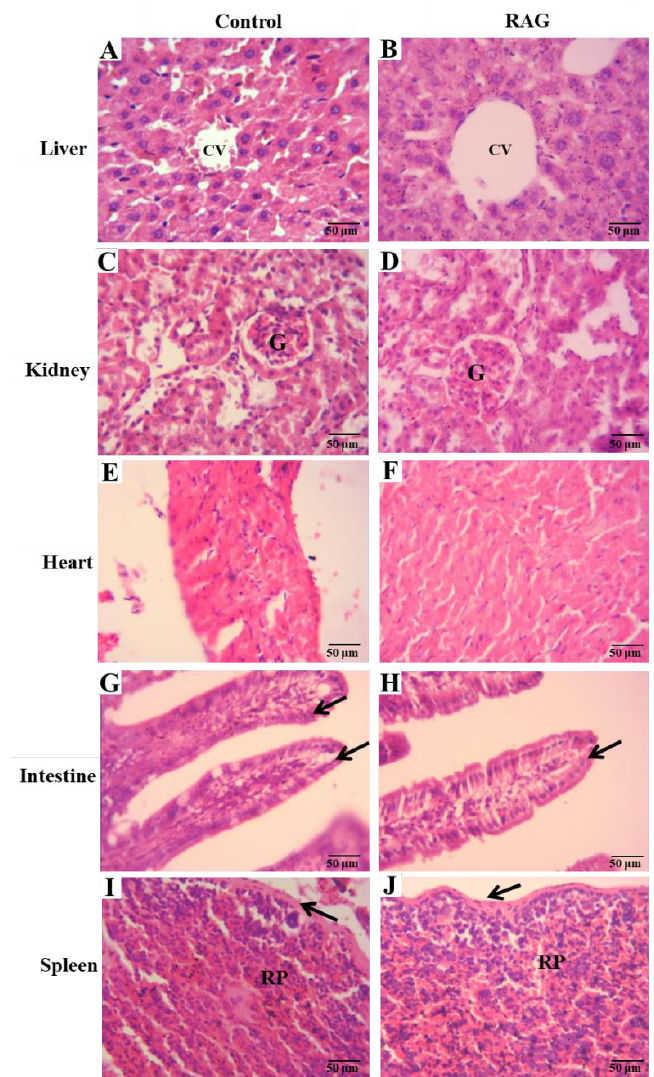
Figure 9. Micrographic characterization of histopathological changes in the organs 14 days after single oral administration of RAG (2000 mg / kg). ( A ) Indicates the hepatic tissue of the saline group (control) and ( B ) the RAG group, both groups, did not show histological changes. CV, central vein; Renal cortex of: ( C ) control and ( D ) RAG groups, with both groups presenting typical renal corpuscle with glomerulus ( G ) and normal capsular space surrounded by Bowman’s capsule, around the corpuscles are the regular proximal convoluted and distal convoluted tubules; Heart: ( E ) control group and ( F ) RAG group demonstrating normal heart tissue, no necrosis nor neutrophil infiltration; Intestine: ( G ) control group and ( H ) RAG group illustrating typical mucosa, absence of necrosis, and neutrophil infiltration with normal characteristics of epithelial cells (arrows) and goblet cells. Spleen: ( I ) control group and ( J ) RAG group demonstrating habitual architecture, red pulp [RP] and capsule of connective tissue indicated by arrows. Hematoxylin and eosin staining in ( A – J ); original magnification 150 ×